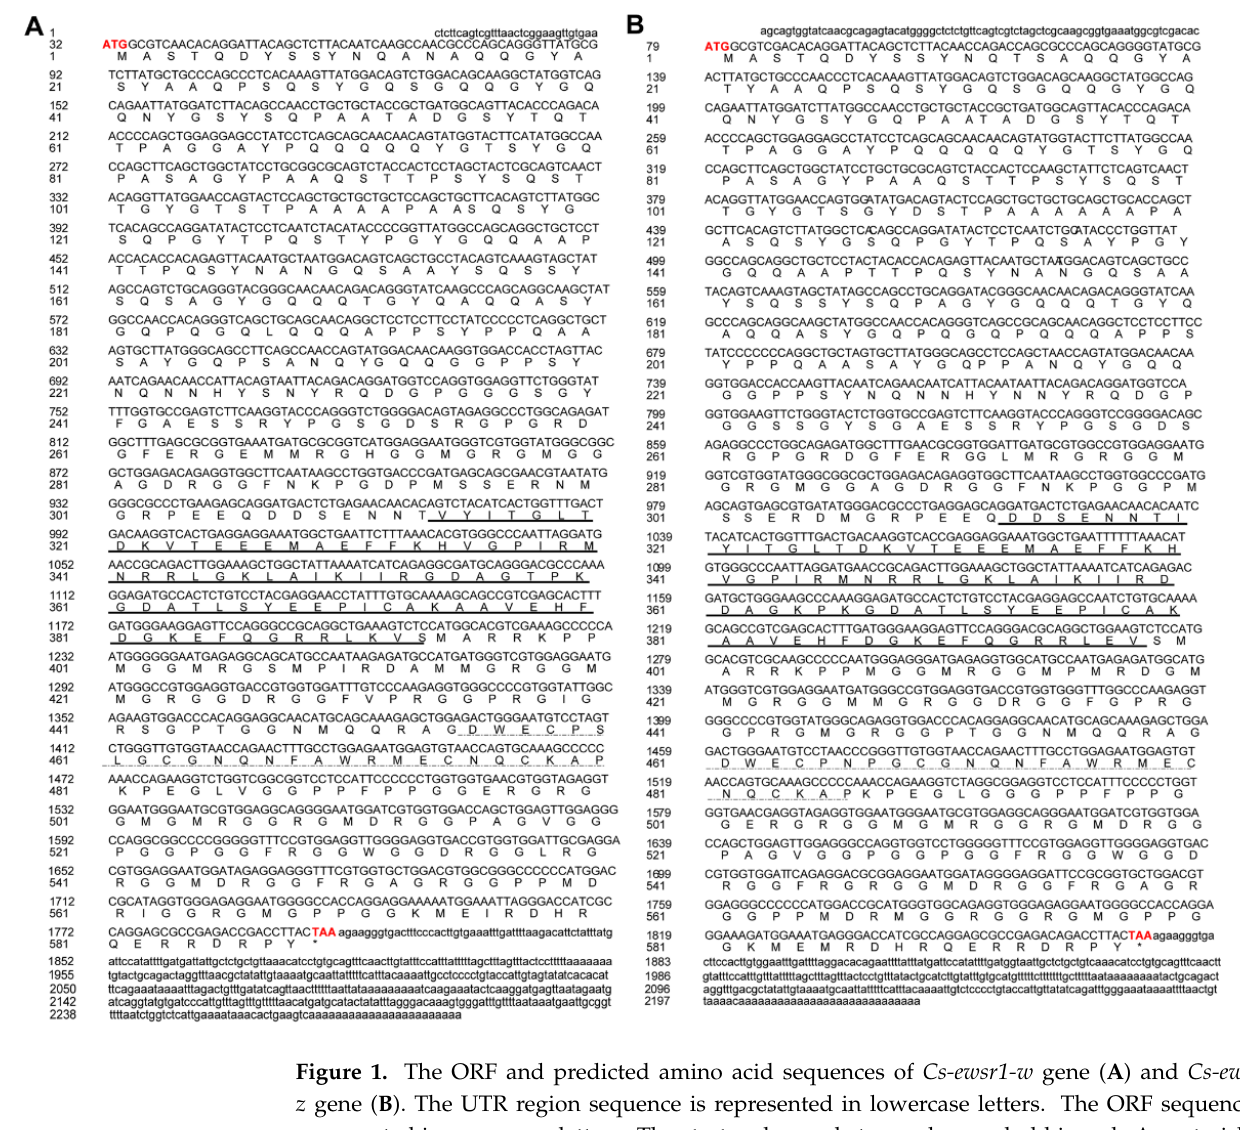
(Figure 1B). The same functional domains were located at 313–399 and 460–486 in Cs-Ewsr1- Z, respectively.